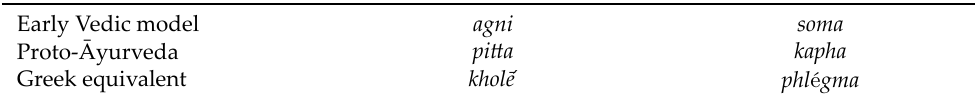
Table 3. Models of ancient medicine